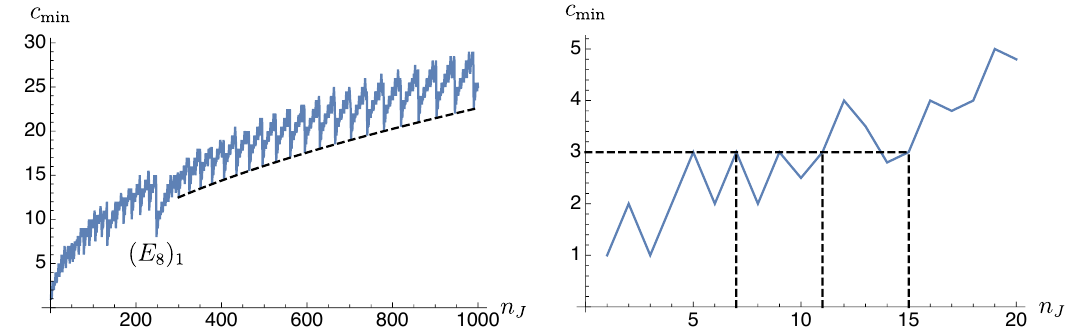
= 1000. The dashed , up to n J J ≥ 300. Right: The same J = 7,11,15, J